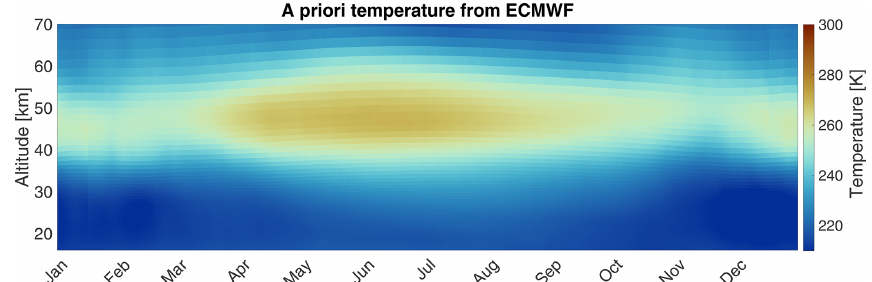
Figure 2. Averaged ECMWF temperature profiles for the geolocation of Payerne (CH). A moving window of 31d was used for smoothing after the average over the 4 years 2014–2017 was